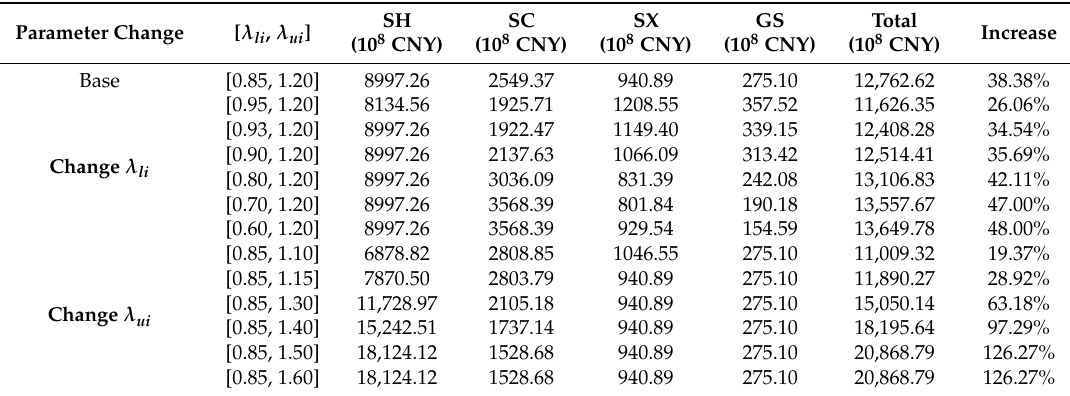
Table 14. Results of the sensitivity analysis for the